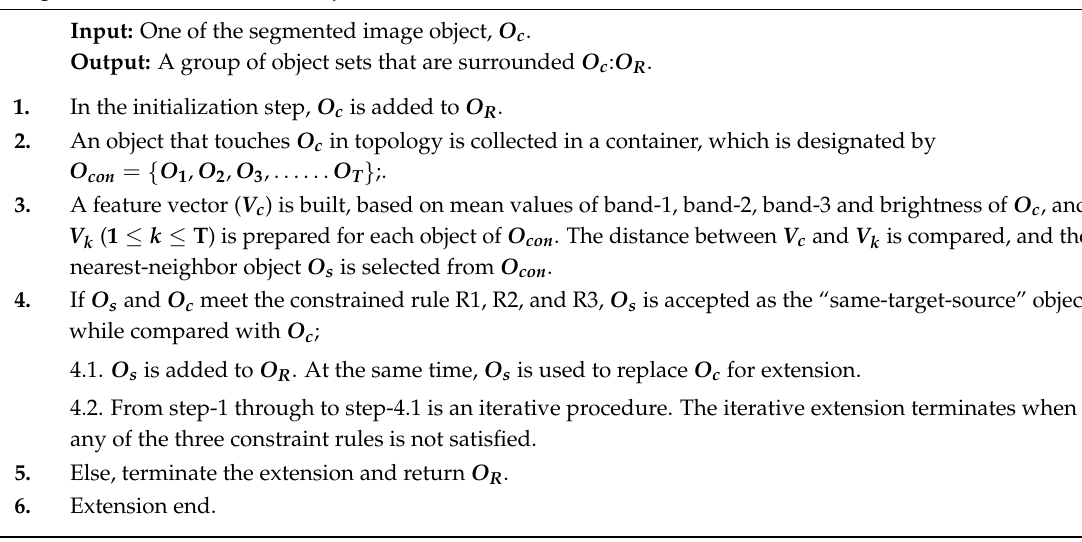
Algorithm 1. Extension of an object